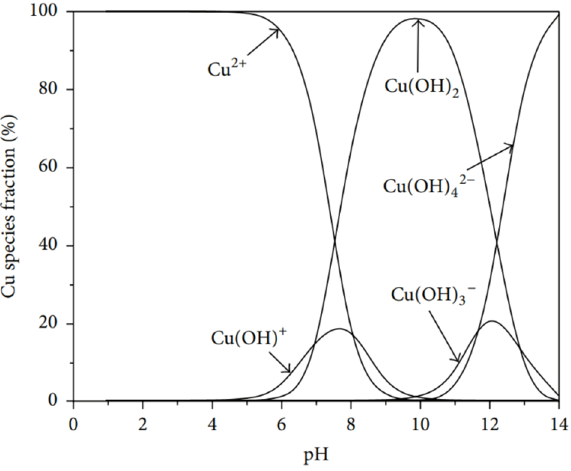
Figure 3. Cu species distribution at different pH values of the solution [10].